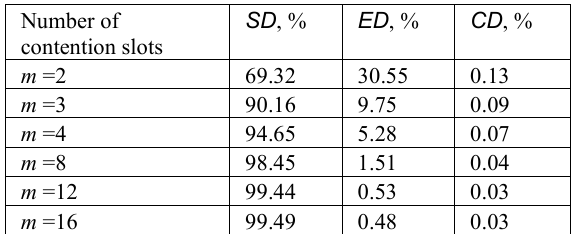
Table II. Average distribution of data slots into successful, empty, and